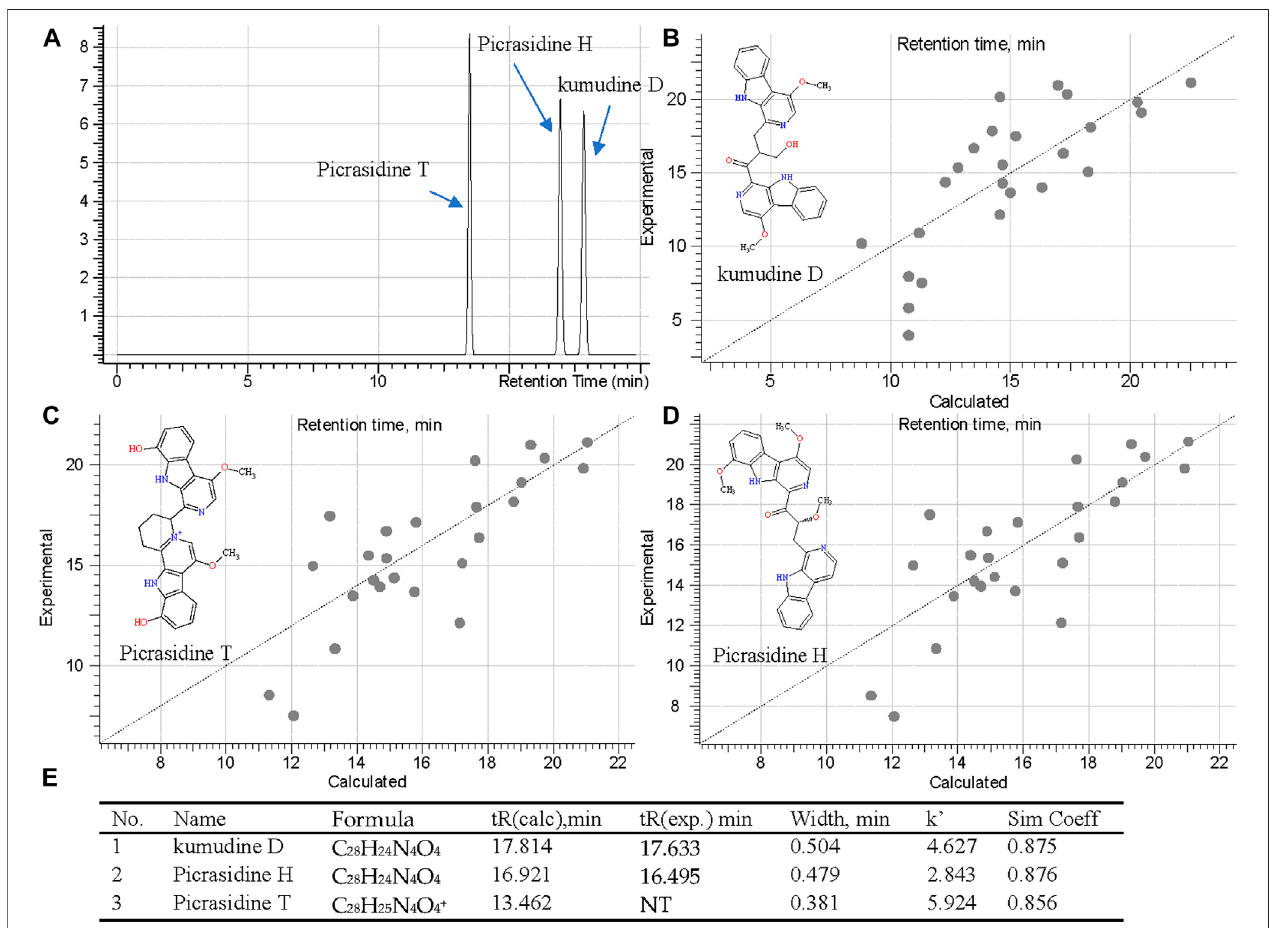
FIGURE 7 | Retention time prediction in chromatography (A) , regression curves of three isomers [kumudine D (B) , picrasidine T (C) , and picrasidine H (D) ] via ChromGenius and the calculation parameters (E) .